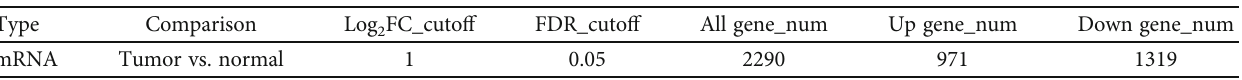
Table 2: Results of the di ff erential overlapped mRNAs from the merging datasets of GSE133624 and TCGA BLCA.